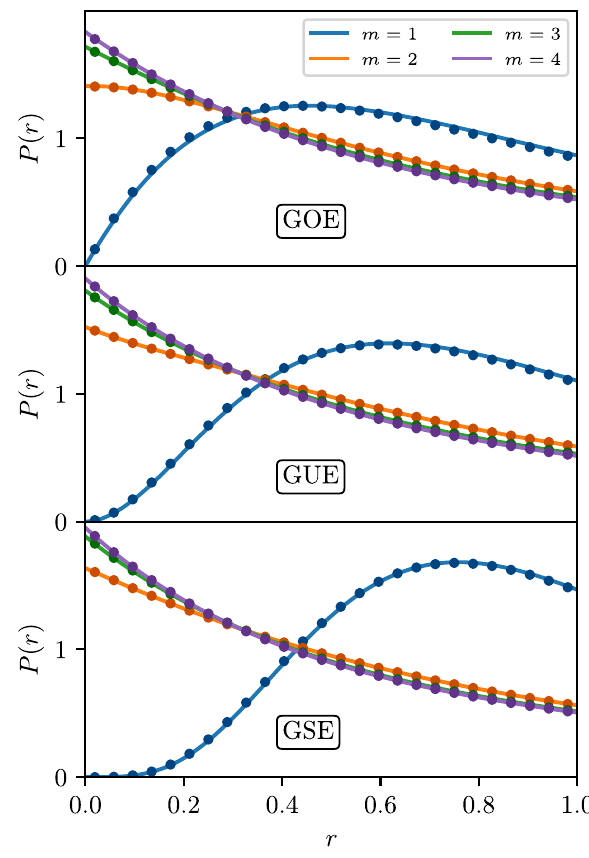
FIG. 2. Distribution of the ratio of consecutive level spacings P ð r Þ for (from top to bottom) GOE, GUE, and GSE ensembles and m ¼ 1 to m ¼ 4 blocks (from bottom to top at r ¼ 0 ). Solid lines are the surmises obtained from Sec. III, except the m ¼ 1 case, for which the corresponding surmise Eq. (7) is taken from Ref. [18]. Points are numerical results from random matrices of 2000 , averaged over 3 . 6 × 10 5 size at least N tot ¼